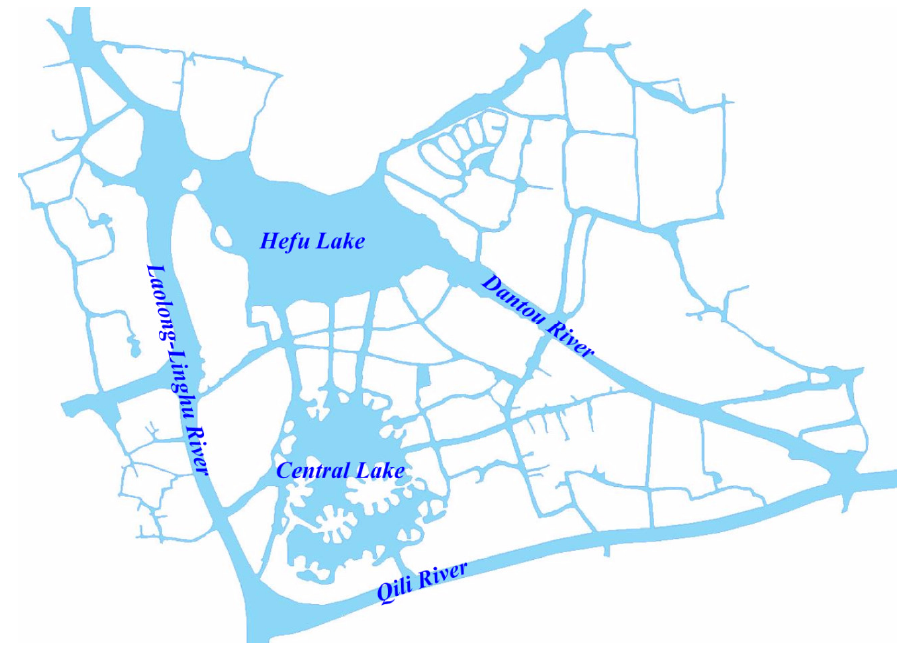
Figure 2. Adjusted water system